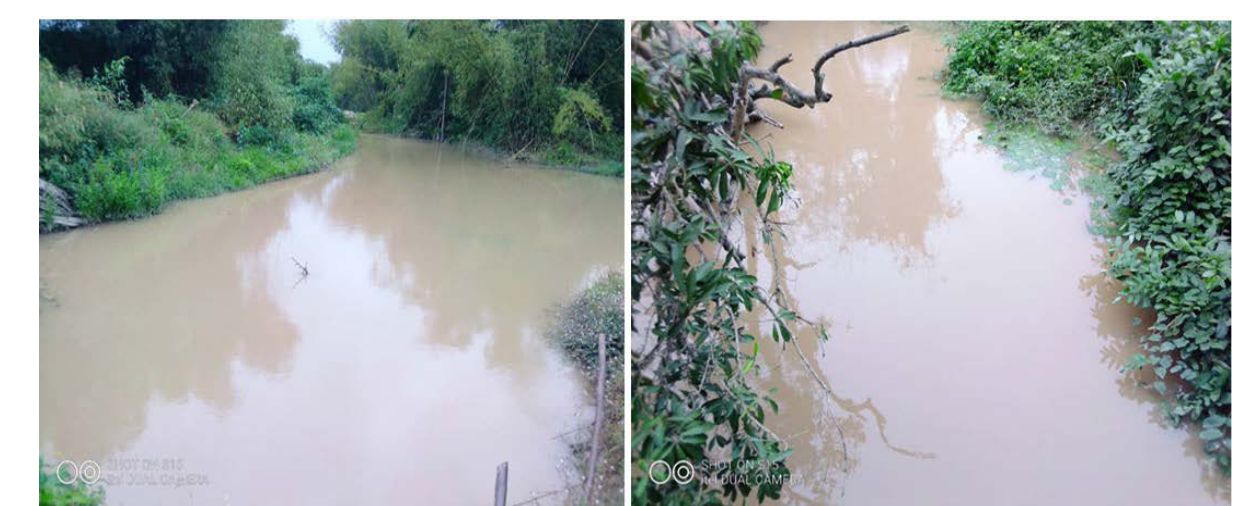
Figure 8. Subri River and Broma River are heavily polluted by large-scale mining activities (effluent) in Ellembelle, August (2020).